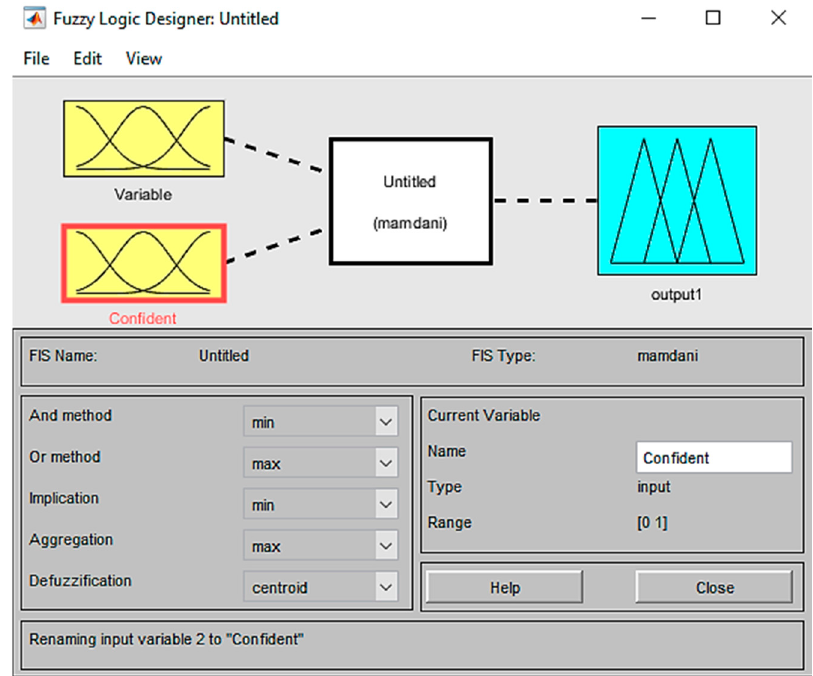
Figure 11. FIS system for the proposed fuzzy–TOPSIS heuristic.